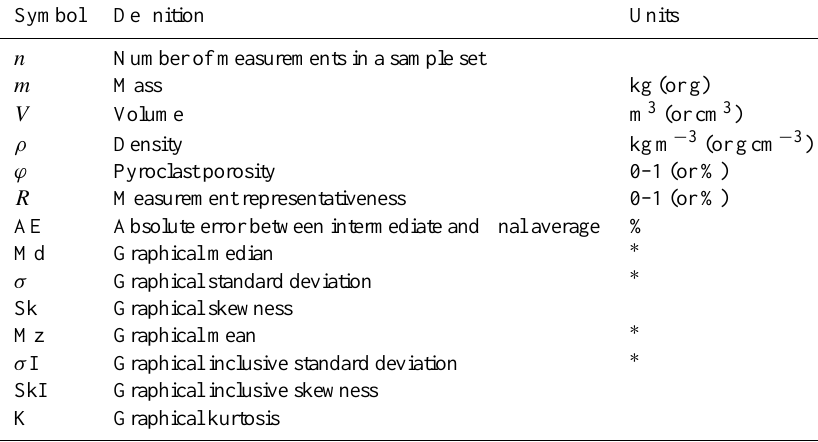
Table A1. Summary of the symbols used in this